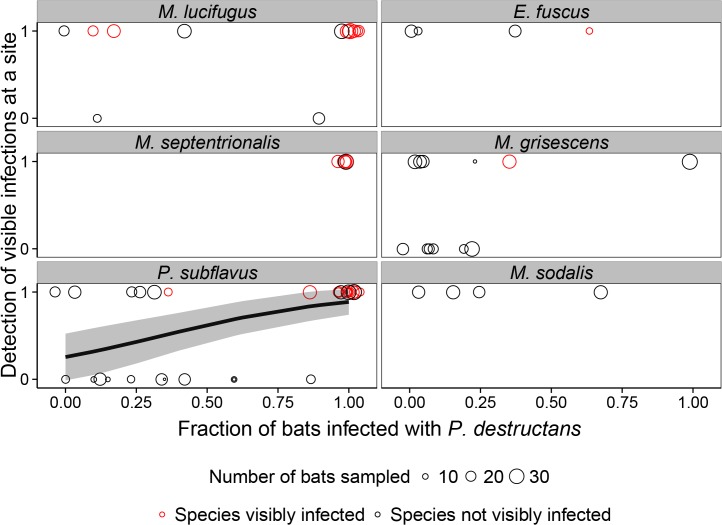
Detection of visible Pseudogymnoascus destructans on bats at hibernacula and the fraction of bats with P. destructans at that site as determined by qPCR.Circles represent sites where a species was sampled, with red circles indicating sites where at least one individual of that species had visible fungus and black circles indicating sites where no individuals of that species were observed with visible fungus. The size of the circles is scaled to the number of bats sampled at a site. The x-axis shows the proportion of bats that were positive for P. destructans by qPCR and the y-axis shows whether at least one individual bat at that site of any species was negative (0) or positive (1) for visible fungal infections. Prevalence of infection was a significant predictor for detection of visible infections at a site for a single species, P. subflavus. Solid black line and gray shading for P. subflavus represent the best-fit line and 95% confidence band for the relationship between prevalence of infection and detection of visible infections at hibernacula.